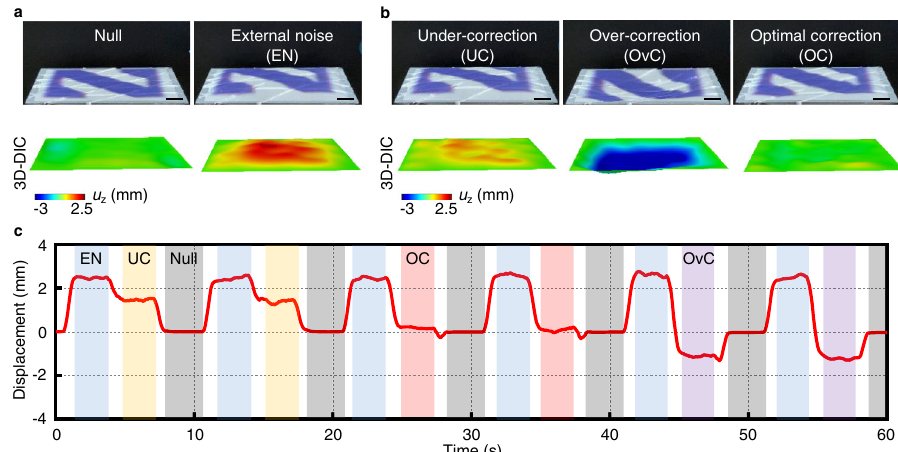
Fig. 5 Noise canceling capability. a Optical (top) and 3D-DIC images (bottom) of the programmable surface with the letter “ N ” projected onto it (left) and bulging upwards due to external vibrational noise (right). b Optical (top) and 3D-DIC images (bottom) of the programmable surface actuated with different current intensities to fi nd the optima to cancel the noise effect. c The maximum displacement on the surface as a function of time at different phases of noise cancellation. Scale bars, 5 mm.